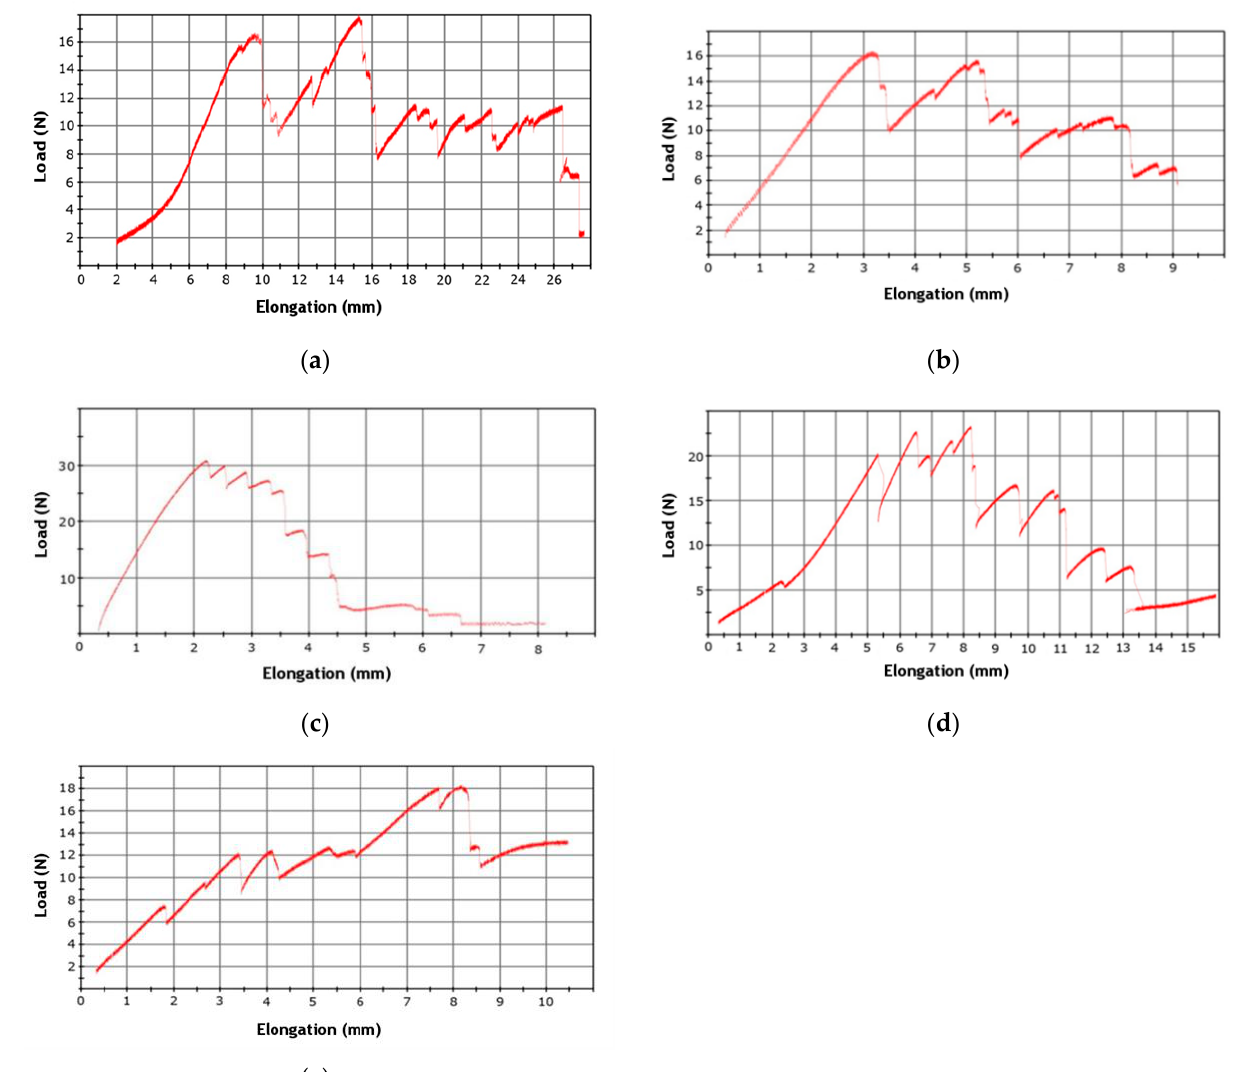
Figure 9. Load-elongation diagrams for ( a ) the reference sample; ( b ) sample P7D_Shd located in the shade; ( c ) sample P7D_Shd-Grass covered by grass in the shade; and ( d ) sample P8D_Sun located in the sun; and ( e ) sample P10D_Slid taken from under the landslide layer. Sharp increases in load are associated with successive filament breaks.